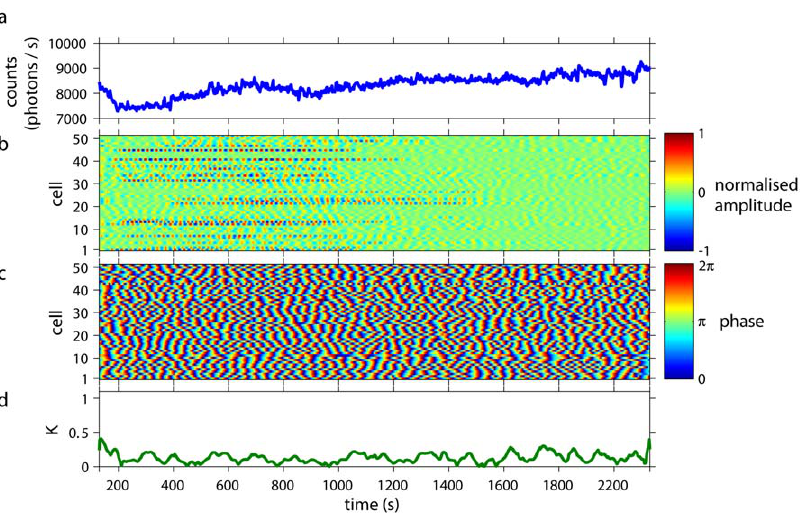
Figure 8. Collective and individual dynamics of S.cerevisiae at a cell density of 0.04%. At t =0 an aliquot of 52 mM glucose was added to the starved and immobilised cells. (a) The time-series of the macroscopic, collective fluorescence signal is quiescent. (b) The individual S. cerevisiae cells remain oscillatory, even at this low cell density. The normalised oscillation amplitudes of the individual cells are decoherent. The amplitude of the oscillations of the cells corresponds to 15–45 photons/s.) Note, that the duration and the onset of pronounced oscillation amplitudes in the individual cells vary considerably from cell to cell. The cells are numbered randomly. (c) The plot of the phases of oscillations shows that each cell oscillates with its own phase and oscillation period. (d) The time-dependent Kuramoto order parameter K remains low, indicating a complete desynchronisation among the oscillations of the individual cells.